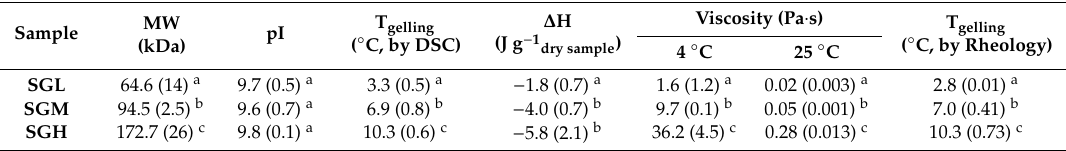
Table 2. Physicochemical properties of SG samples; low (SGL), medium (SGM) and high (SGH) controlled molecular weight (MW, by capillary viscometry): isoelectric point (pI), gelling temperature by calorimetry, and rheology, gelation enthalpy, and viscosity (at 4 ◦ C and 25 ◦ C). Values in brackets correspond to standard deviation (n = 3). Within the same column, di ff erent superscript